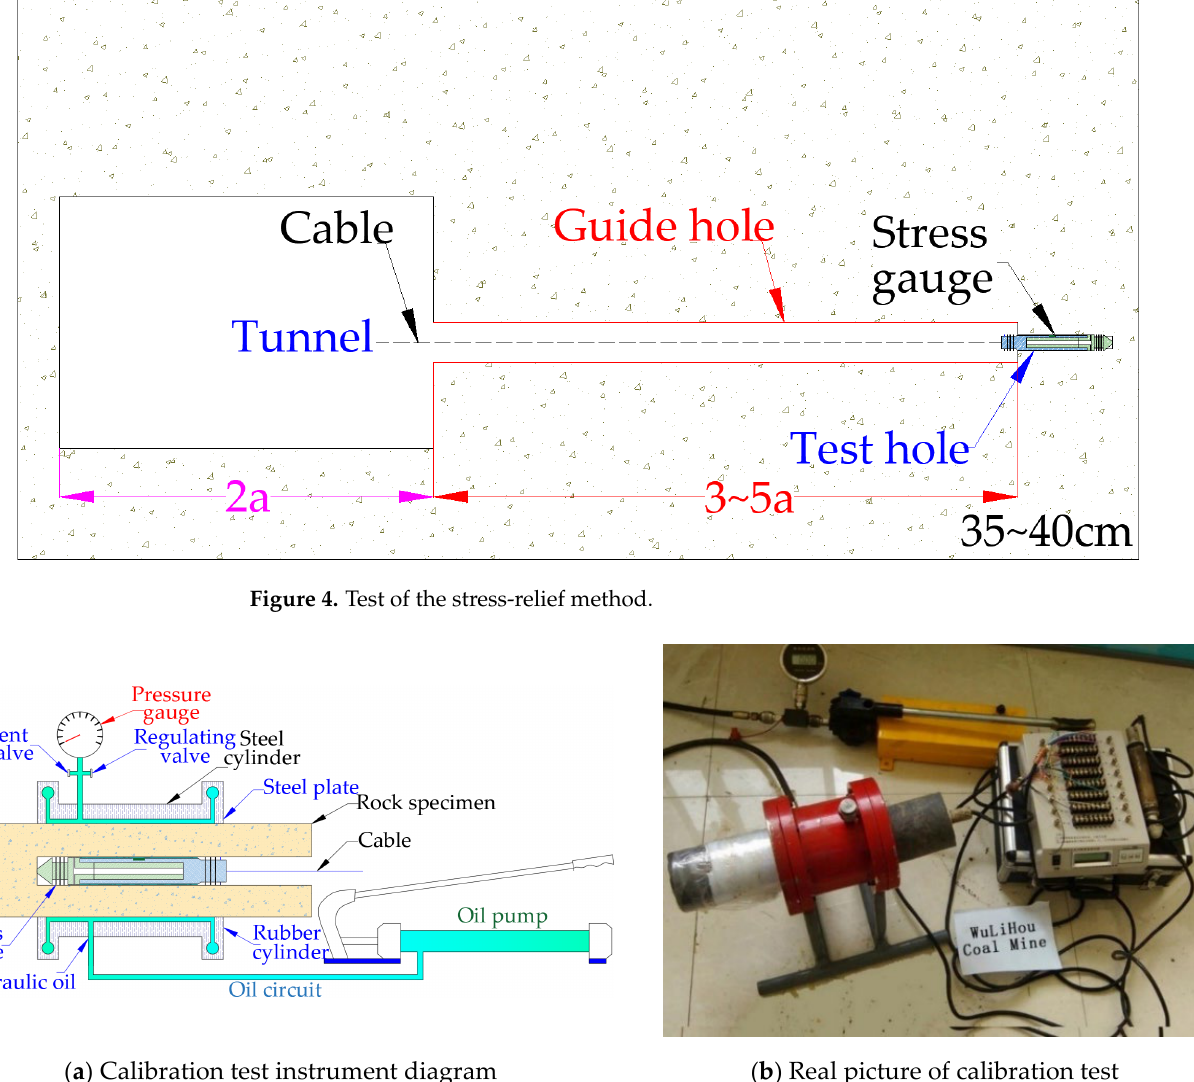
Figure 5. Calibration test instrument.